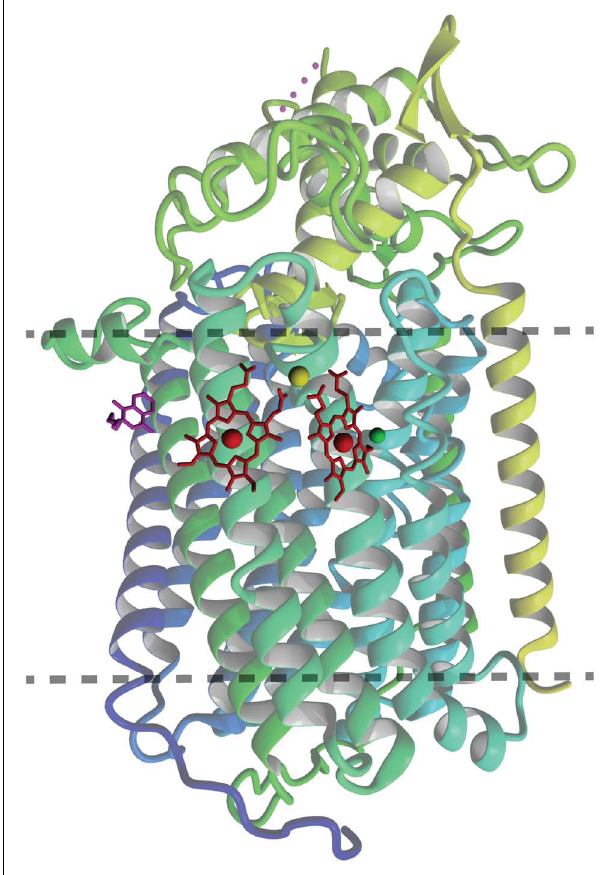
FIGURE 3 | Ribbon representation of the overall qNOR structure of Geobacillus stearothermophilus (3AYG, Matsumoto etal., 2012) seen from the plane of the cytoplasmic membrane (between dotted lines). The heme groups are indicated in red, the quinol analog 2-heptyl hydroxyquinoline N -oxide in magenta.The zinc in the catalytic center is shown in green, and the calcium (Ca 2 + ) assisting in coordination of the heme groups in pastel